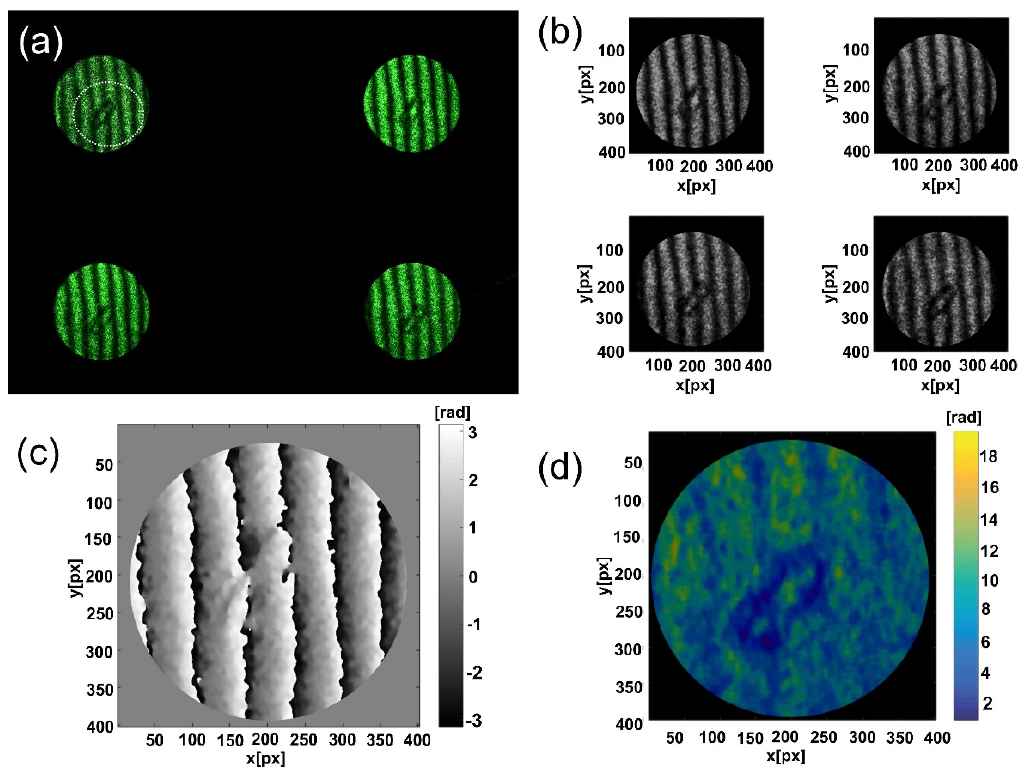
Figure 8. Microarthropod Collembola . ( a , b ) Four simultaneous patterns. ( c ) Wrapped phase. ( d ) Phase map.